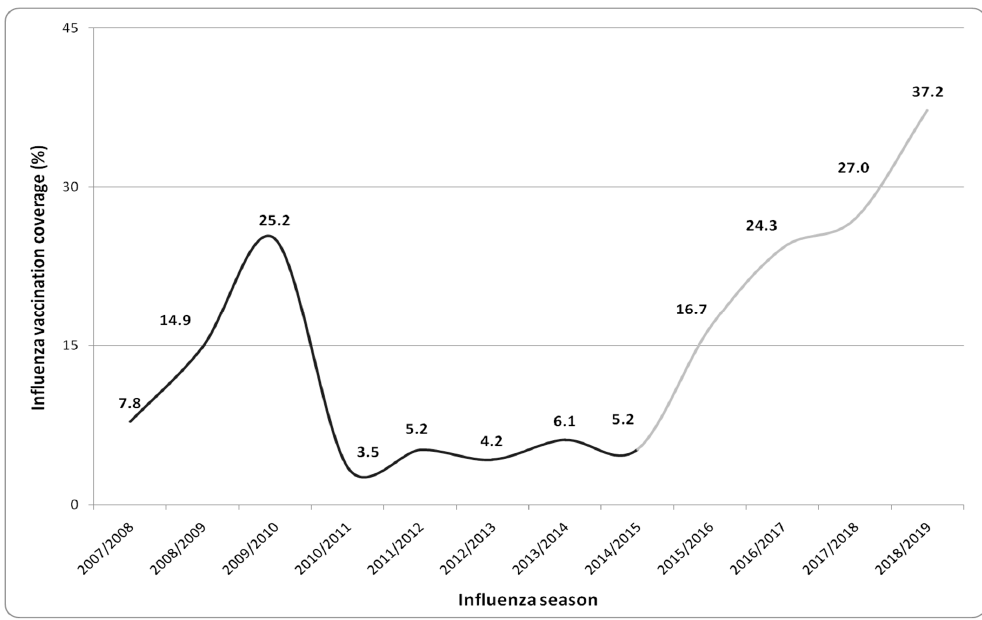
Figure 1. Trend of influenza vaccination coverage rates of health-care professionals working at the University Hospital of Palermo from the 2007/2008 to 2018/2019 season. (In light grey, the seasons during which the different strategies described in Table 1 were adopted).